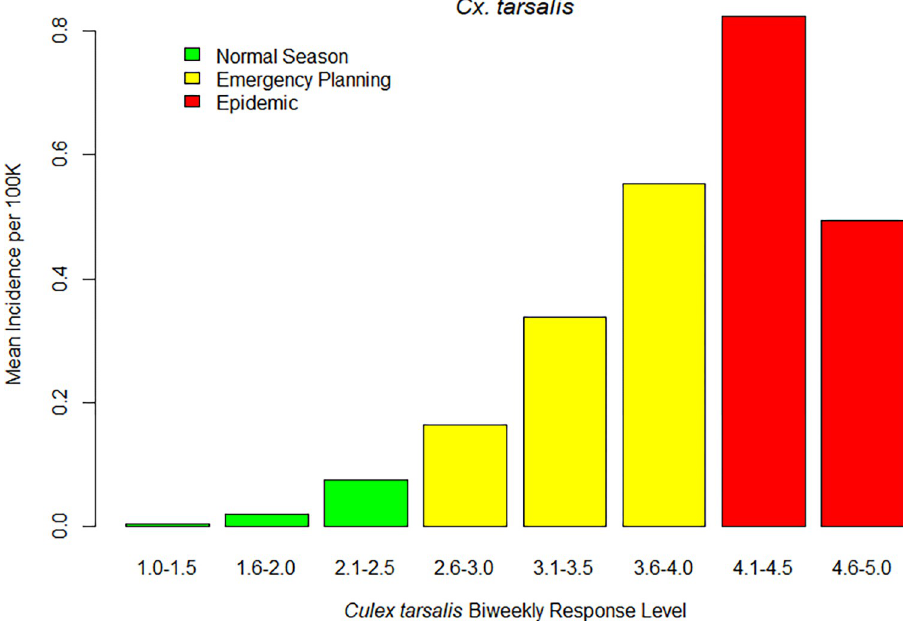
Fig 2. Observed human WNV disease incidence in 3-week periods versus antecedent biweekly overall risk levels, based on temperature, abundance and at least 1 infection indicator, for Cx . tarsalis in California, 2009–2018.